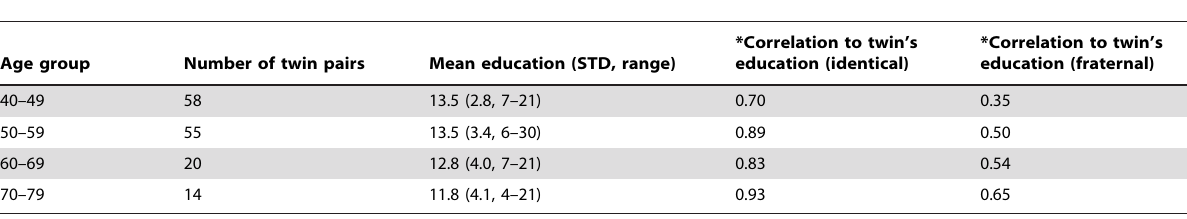
Table 1. Years of education by age- group with identical and fraternal intra-twin correlations.